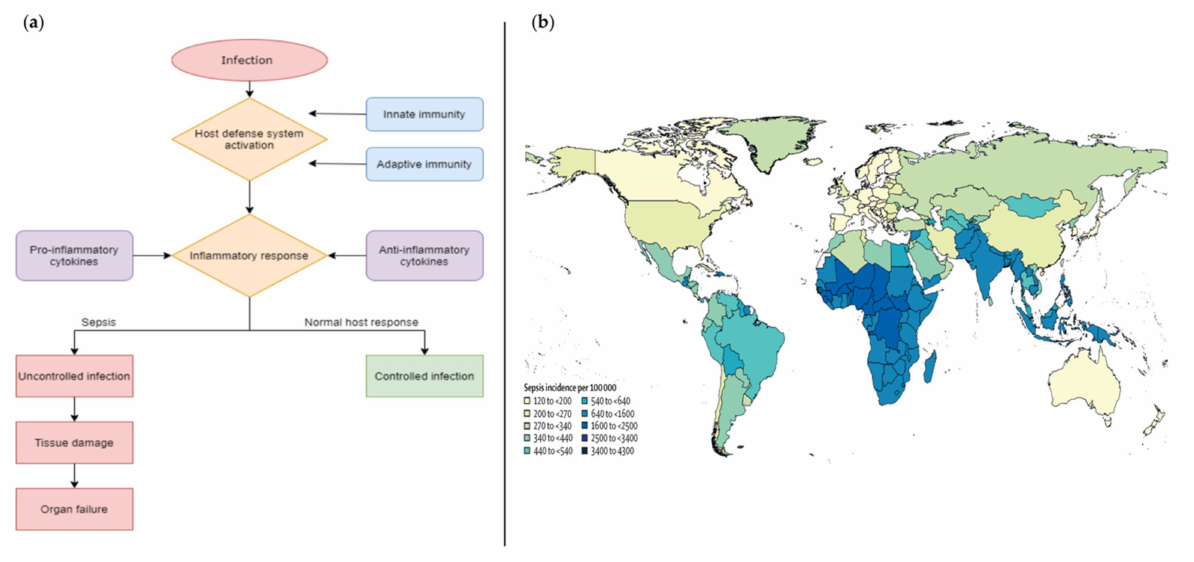
Figure 1. ( a ) comparison of the schematic flow between sepsis and normal host response to an infection; ( b ) geographical incidence of sepsis worldwide [9]. Copyright © 1969,